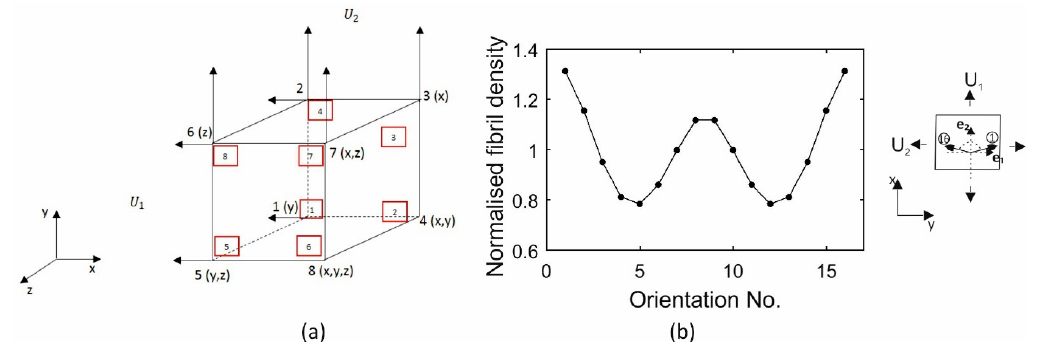
Figure 4. ( a ) Single element model; directions in brackets represent the boundary conditions. Node numbers are in black and numbers of integration points are in red boxes. ( b ) Initial fibril distribution assumed at all integration points.